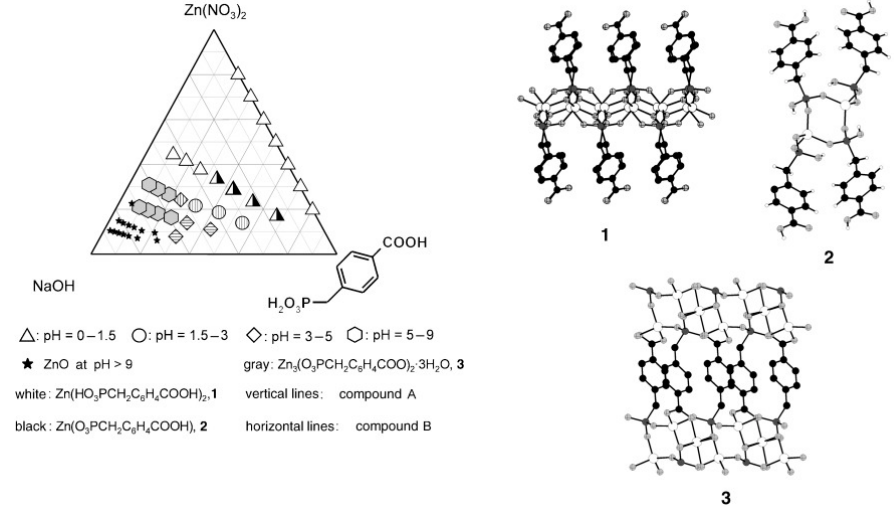
Figure 8. Crystallization diagram of observed phases in the Zn(NO 3 ) 2 / p -H 2 O 3 PCH 2 C 6 H 4 COOH/NaOH system (left). Sections of the structures of Zn(HO 3 PCH 2 C 6 H 4 COOH) 2 (1) , Zn(O 3 PCH 2 C 6 H 4 COOH) (2) , and Zn 3 (HO 3 PCH 2 C 6 H 4 COO) 2 · 4H 2 O (3) (right). Colour code: Zn: white, C: black, P: dark grey, O: light grey. Reprinted with permission from reference. [40]. Copyright 2004, Wiley-VCH Verlag GmbH & Co.